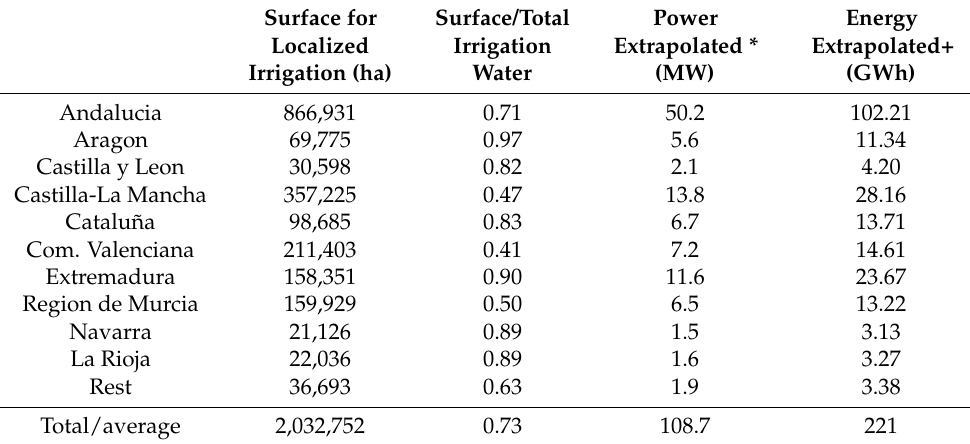
Table 7. Power and energy potential estimates for MHP from the analysis of regions containing pressurised irrigation networks in Spain. Surface for Localized Irrigation